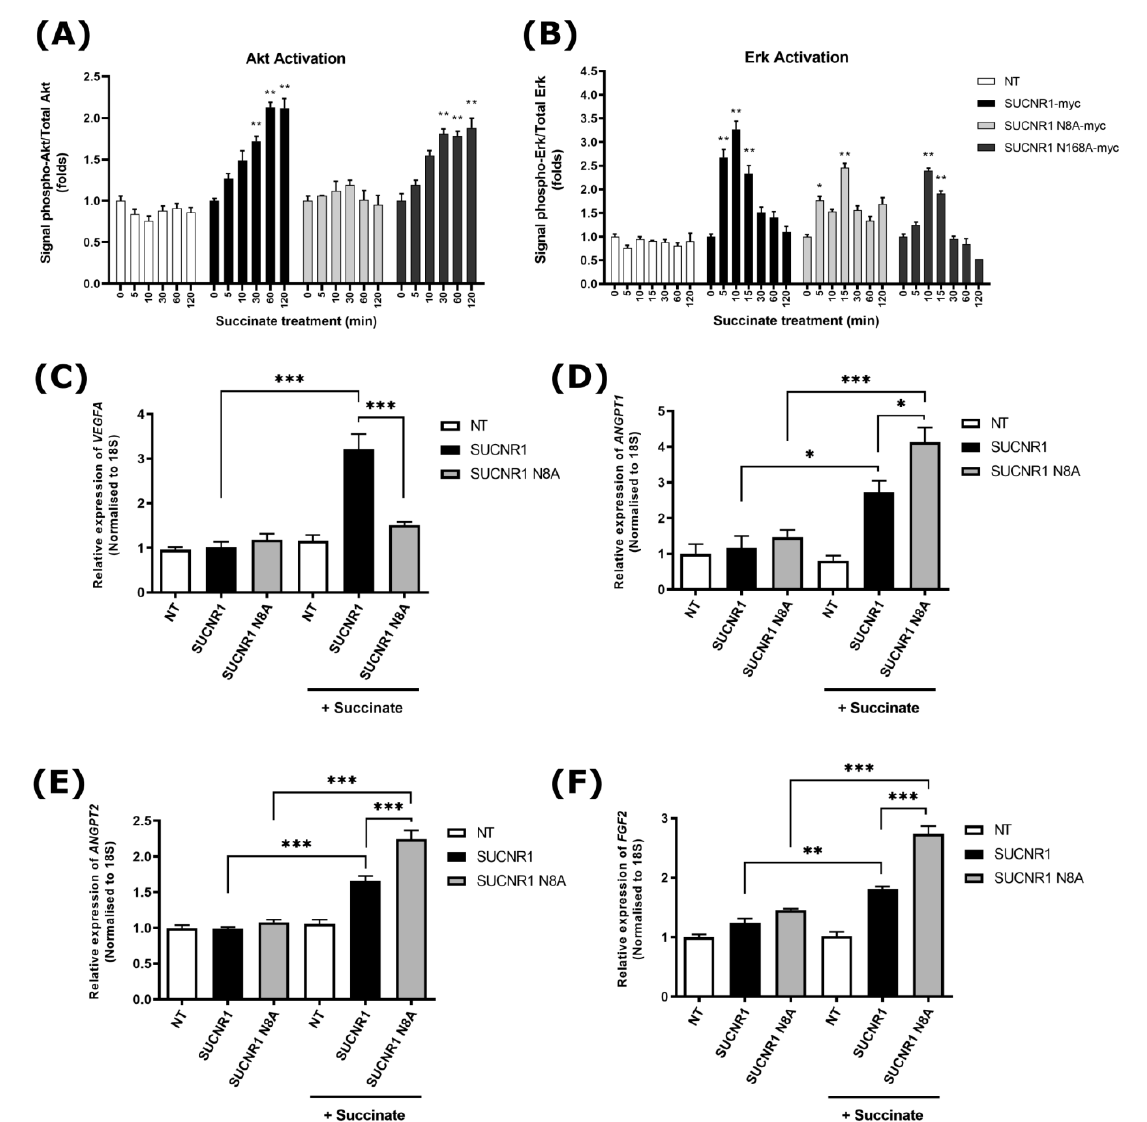
Figure 3. Impaired signaling downstream of N-glycosylation mutant SUCNR1. ( A ) Signal ratio of phospho- to total AKT level was measured in HEK 293T cells transiently transfected with the wild- type or glycosylation mutants SUCNR1 and treated or not with 100 μM succinate for the indicated times. NT: nontransfected. N = 4; * p < 0.05; ** p < 0.01 vs. comparative values. ( B ) Similar to ( A ), except that phosphorylation of ERK1/2 was measured. ( C – F ) Expression of proangiogenic genes VEGFA , FGF2 , ANGPT1 , and ANGPT2 in HEK 293T cells transiently transfected with wild-type or mutant SUCNR1, treated or not with 100 µM succinate for 4 h. NT: nontransfected. N = 4; ** p < 0.01; *** p < 0.001 vs. comparative values.